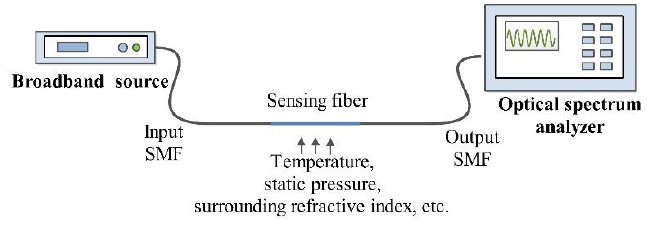
Figure 1. Schematic of the critical-wavelength-existed in-line Mach – Zehnder interferometer measurement system.